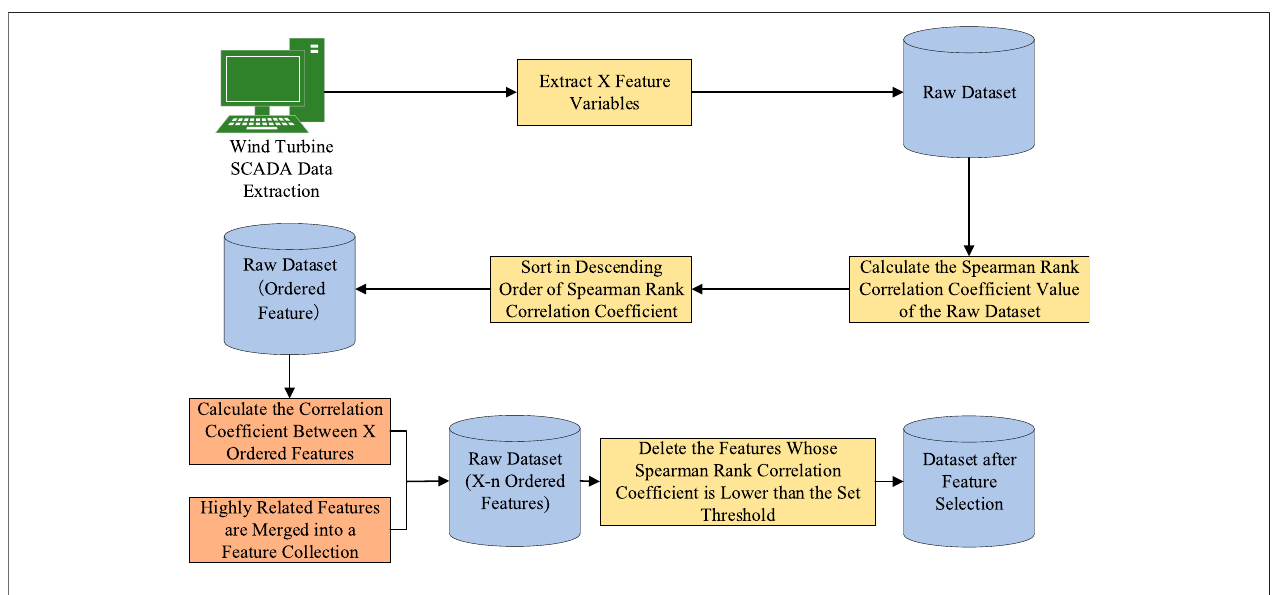
FIGURE 1 | Feature selection based on the Spearman rank correlation coef fi cient.